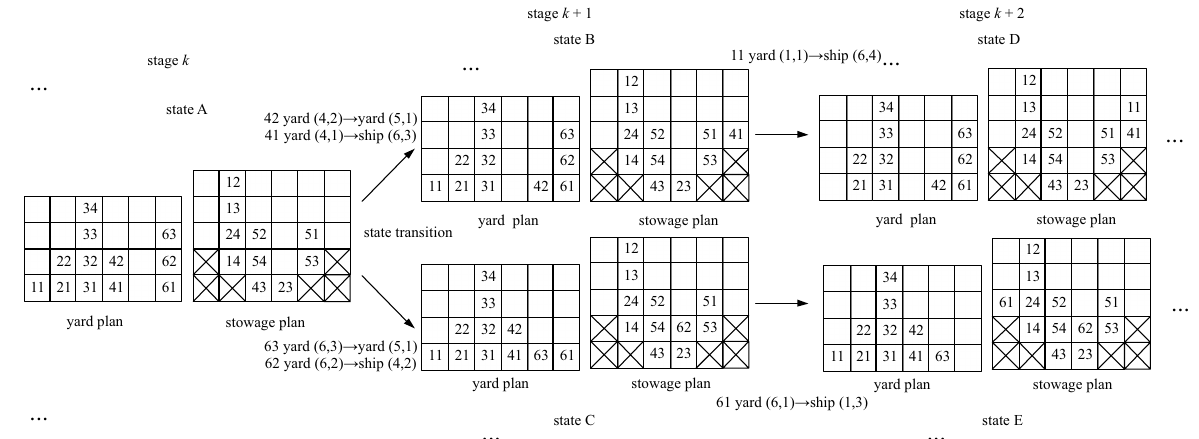
Fig. 4. The state transition of dynamic